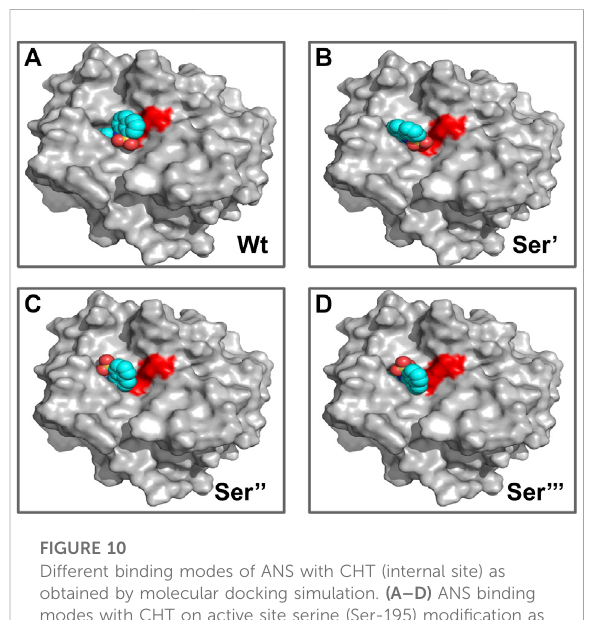
FIGURE 10 Different binding modes of ANS with CHT (internal site) as obtained by molecular docking simulation. (A – D) ANS binding modes with CHT on active site serine (Ser-195) modi fi cation as previously mentioned. [Wt indicates the wild type/ unmodi fi ed CHT].